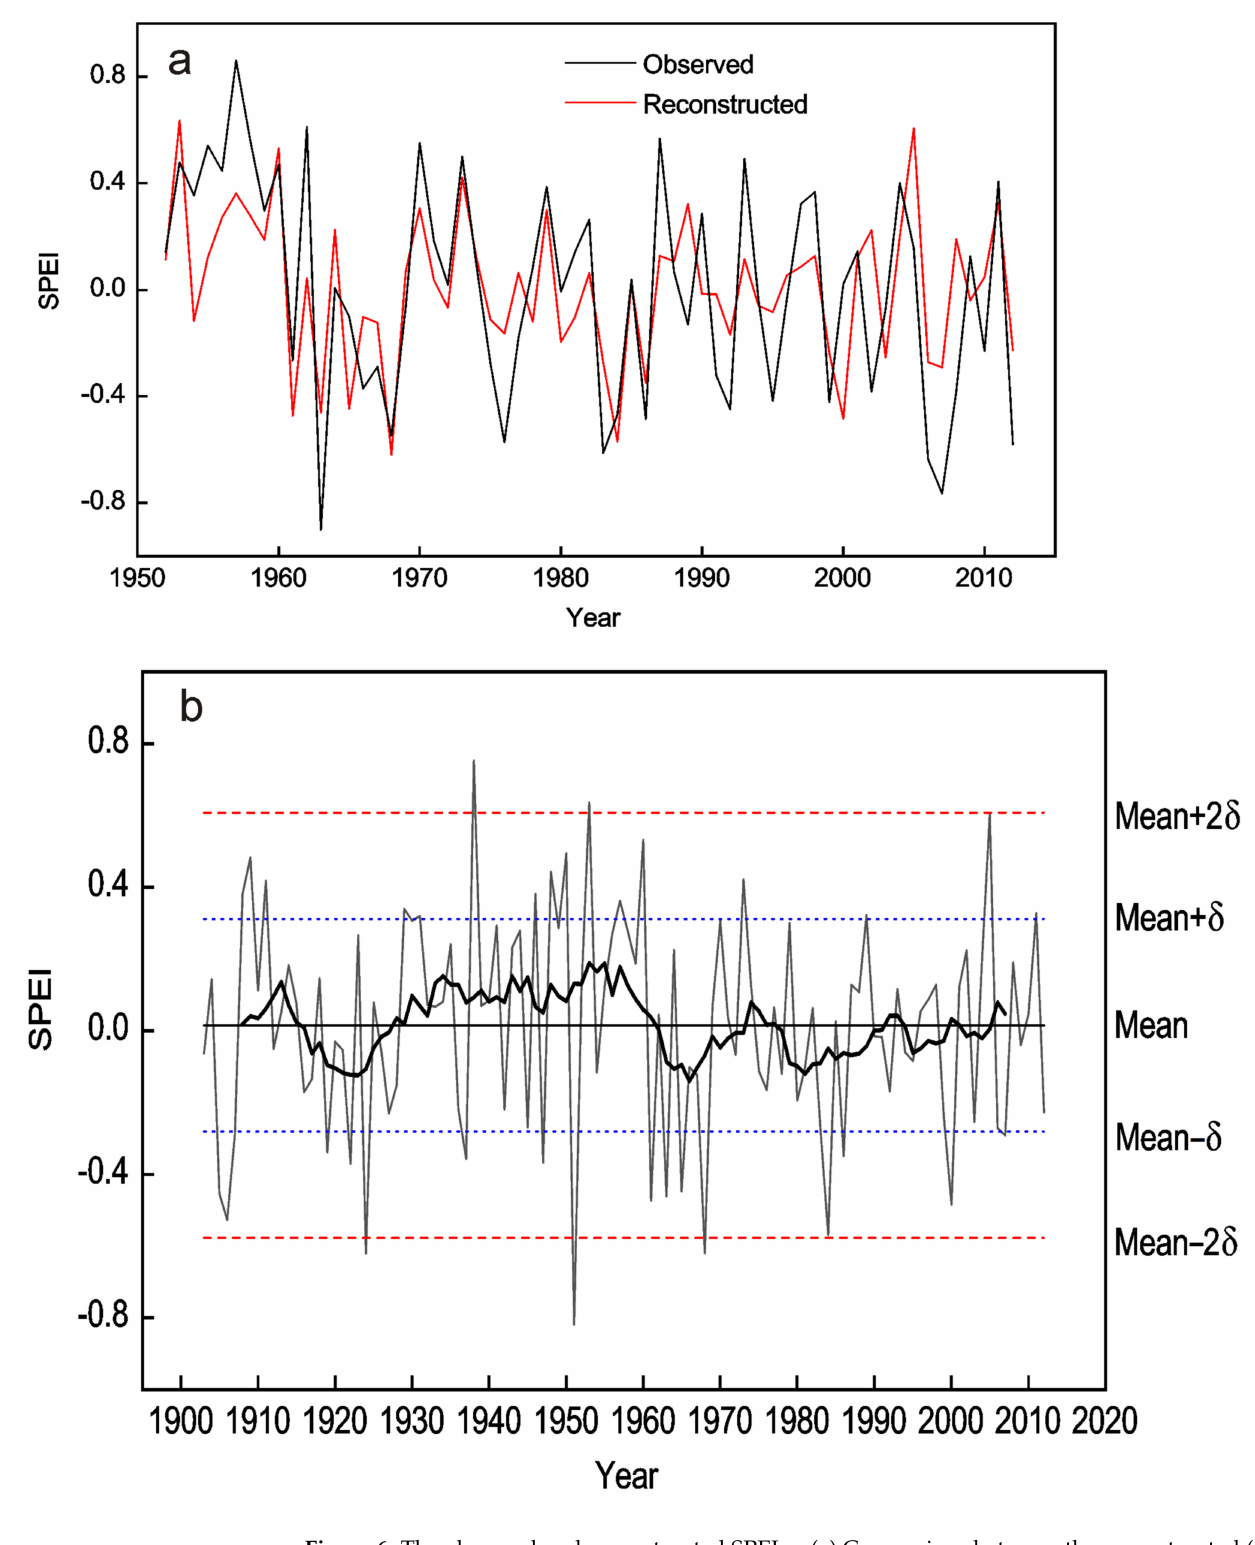
Figure 6. The observed and reconstructed SPEI 82 . ( a ) Comparison between the reconstructed (red line) and observed (black line) SPEI 82 from 1952–2012. ( b ) The reconstructed SPEI 82 (the bold line represents an 11-year moving